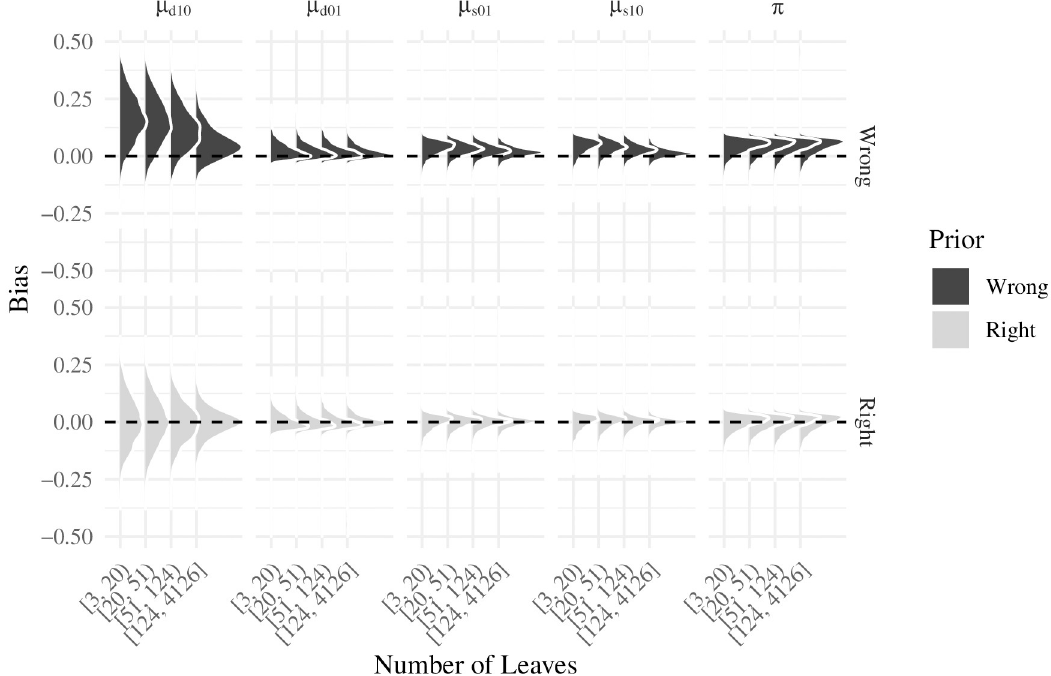
Fig 11. Empirical bias distribution for the Fully annotated scenario by type of prior, parameter, and number of leaves.